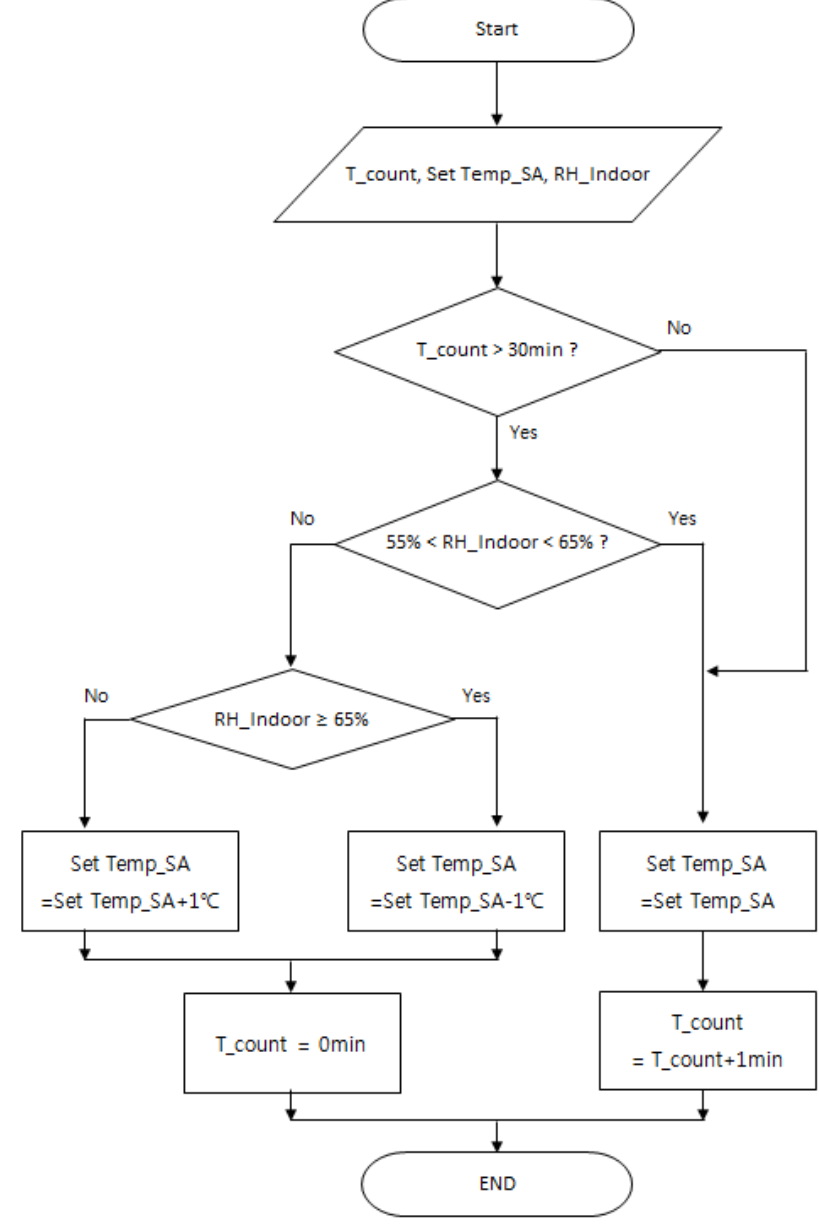
Figure 5. Flow chart of the control algorithm of supply air temperature in the OAP.